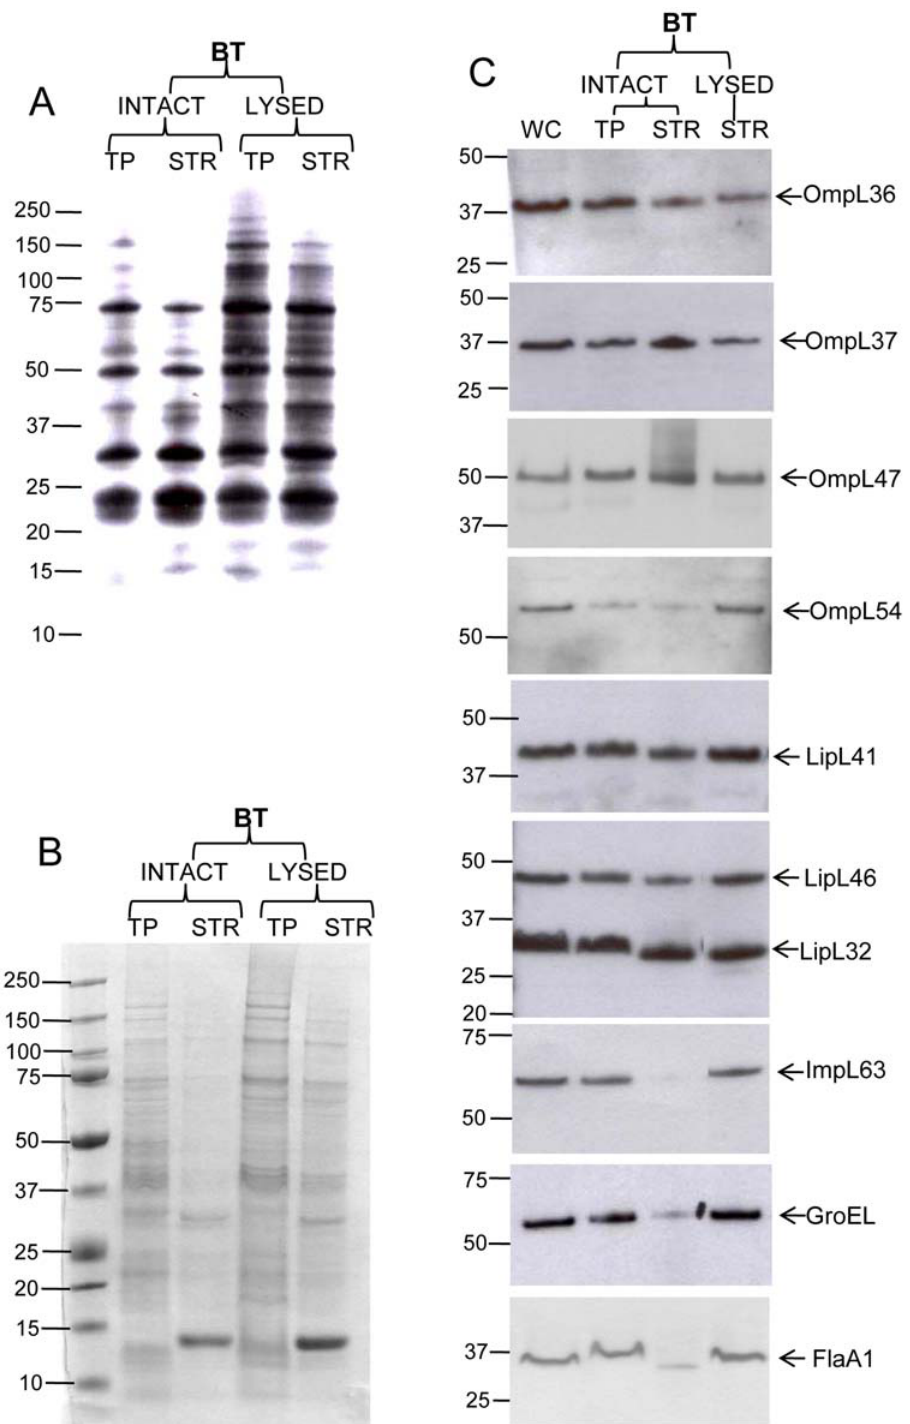
Figure 4. Analysis of biotinylated proteins from intact and lysed Leptospira. Proteins of L. interrogans serovar Copenhageni strain Fiocruz L1–130 were treated with Sulfo-NHS-LC-Biotin (BT) and equivalents of 1 6 10 8 of leptospires per lane were separated on gel electrophoresis (Bis-Tris 4– 12% NuPage gel, Novex). A whole cell lysate without Sulfo-NHS-LC-Biotin (lane WC), a total protein of intact (INTACT) or lysed (LYSED) leptospires after biotinylation (lanes TP) and material captured from biotinylated leptospires by streptavidin affinity gel (lanes STR). (A) Streptavidin blot. Proteins were blotted to PVDF membrane and the biotin labeled proteins detected by streptavidin horseradish peroxide (HRP) conjugate. (B) A Coomassie G- 250 stained gel of samples described above. (C) Immunoblots with specific rabbit sera. The identities of individual proteins are indicated on the right, and the positions of molecular mass standard (in kilodaltons) are indicated on the left.